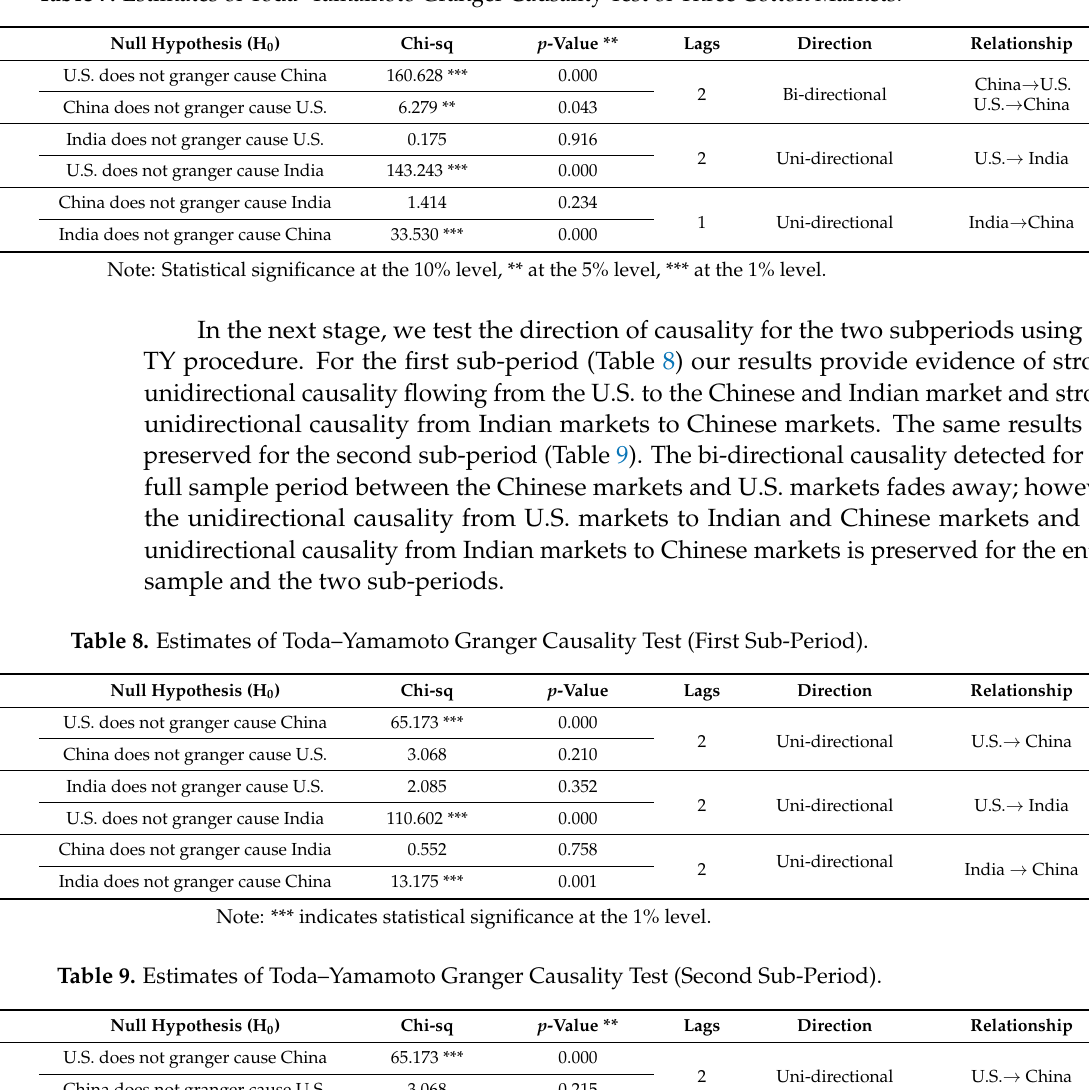
Table 7. Estimates of Toda–Yamamoto Granger Causality Test of Three Cotton Markets.